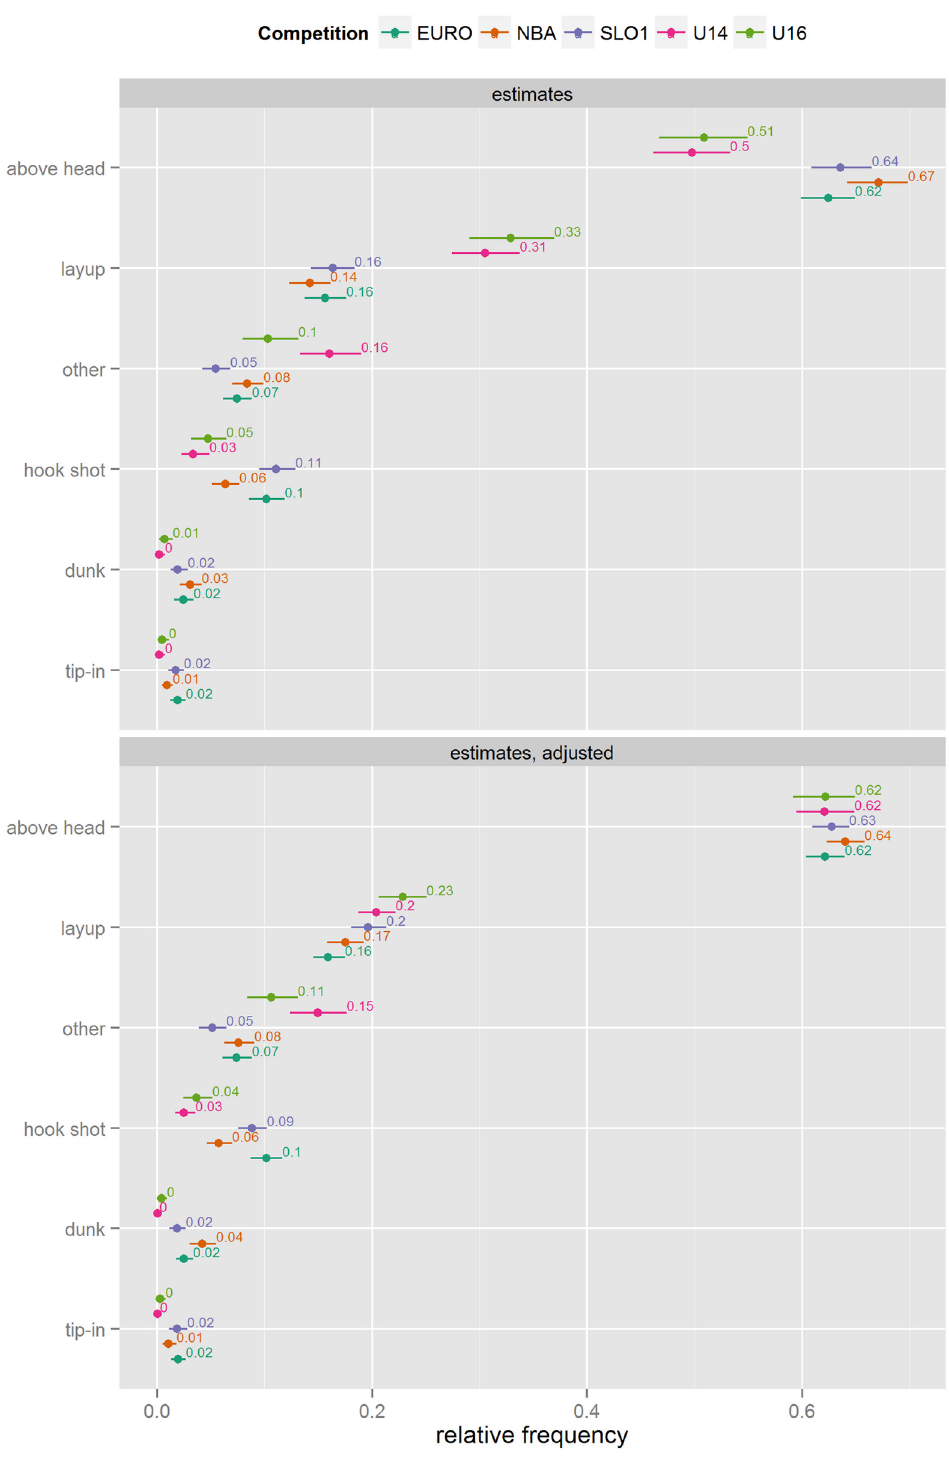
Fig 2. Shot type frequency estimates (unadjusted and adjusted for differences in situational variables).